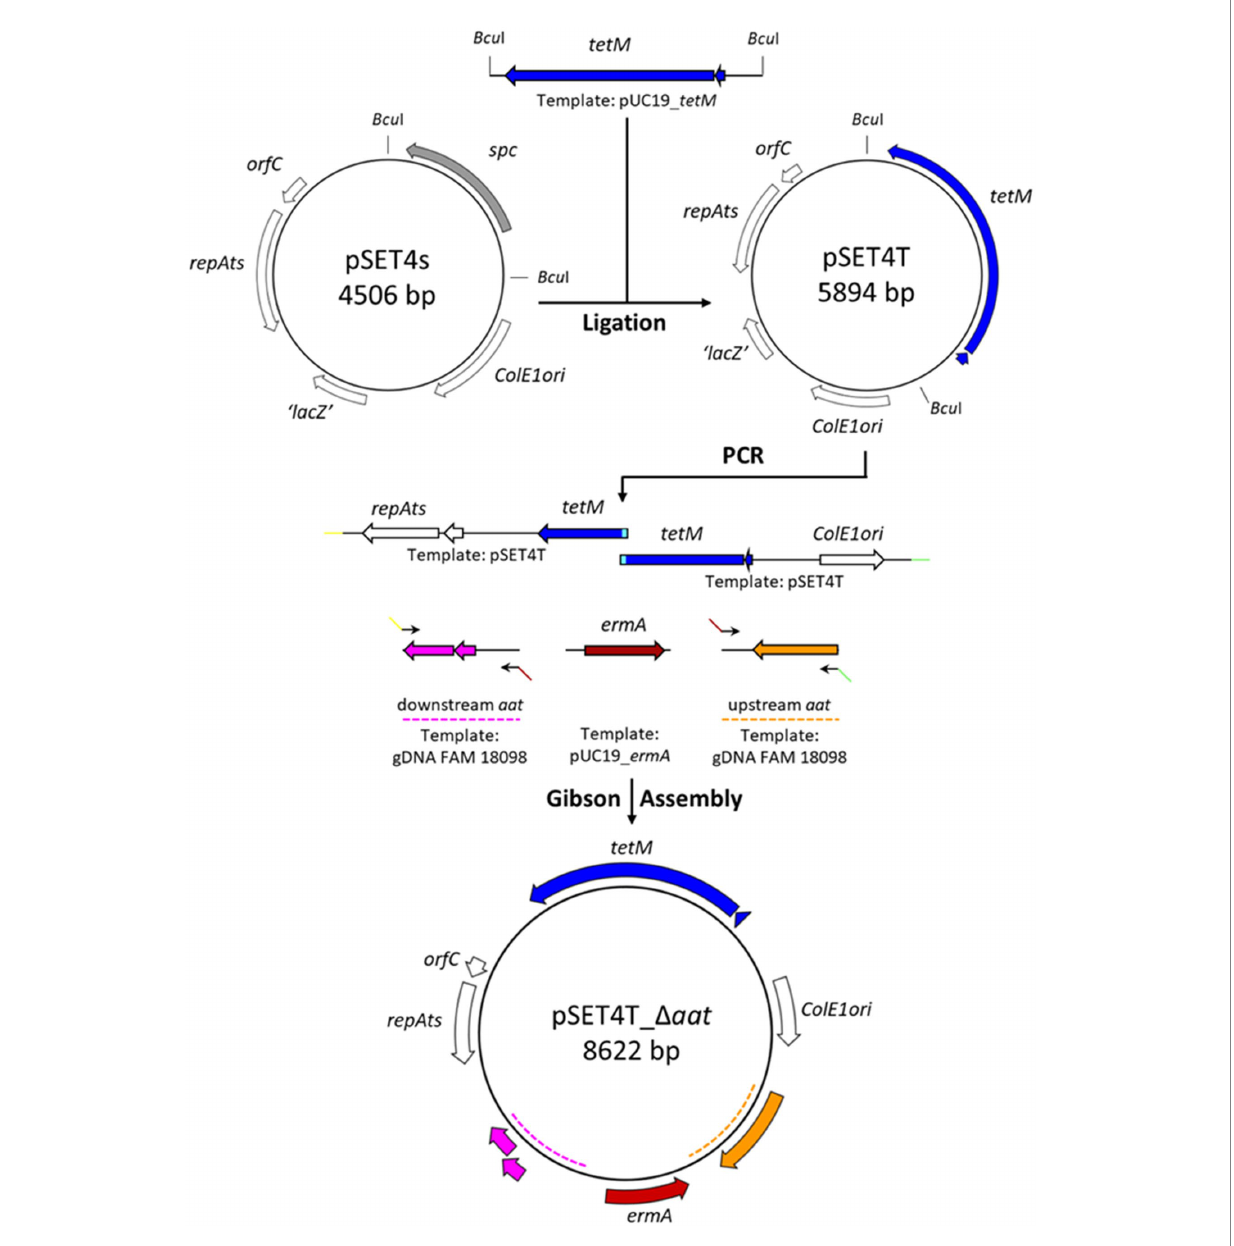
FIGURE 1 Schematic representation of the construction of the gene knockout plasmid pSET4T_ Δ aat . Tetracycline resistance gene tetM was amplified by PCR from pUC19_ tetM vector and ligated into pSET4S using the two Bcu I sites creating pSET4T. The gene replacement vector pSET4T_ Δ aat was constructed by PCR amplification of the plasmid backbone of pSET4T with two overlapping fragments (indicated in light blue). The regions 1-kbp upstream and 1-kbp downstream of aat were amplified from the genomic DNA of P. acidilactici strain FAM 18098 using overhang primers with homologous sequences of the other fragments (indicated by colored arrows). The erythromycin resistance gene ermA was amplified via PCR from pUC19_ ermA . The five fragments were assembled using a Gibson Assembly resulting in pSET4T_ Δ aat . The wide arrows indicate open reading